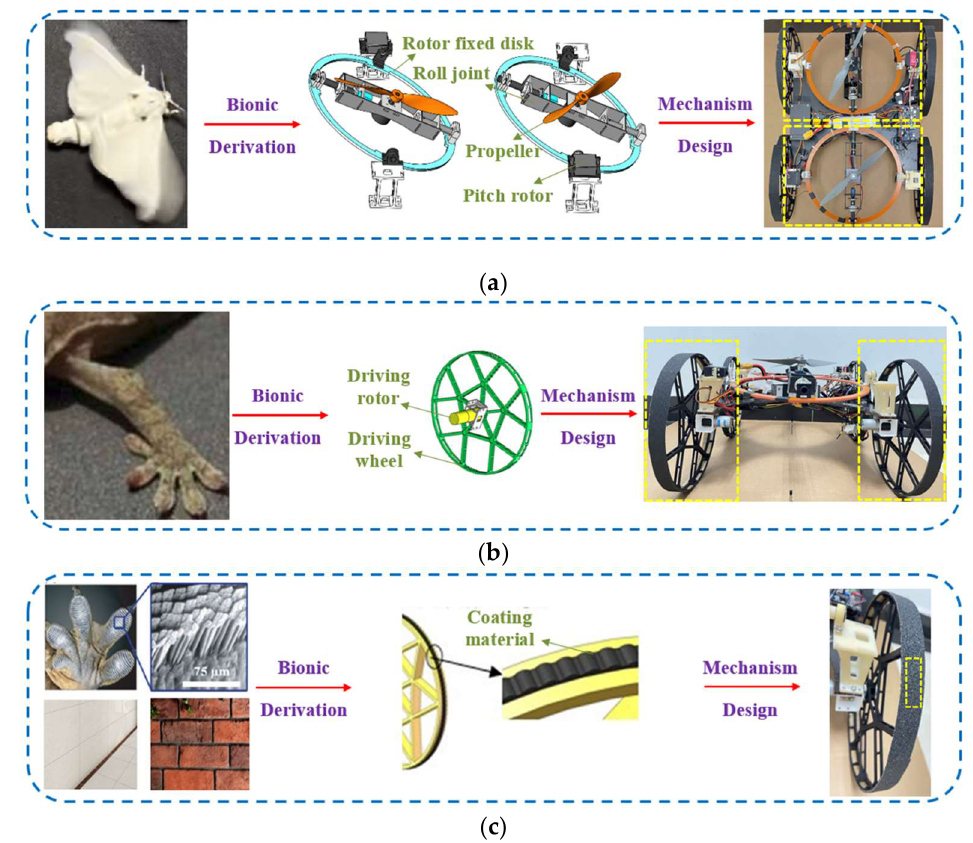
Figure 2. Design of DP-Climb hybrid adhesion system: ( a ) symmetrical rotor bionic joints; ( b ) hind limb drive bionic joints ( c ) a coating material to enhance the friction.